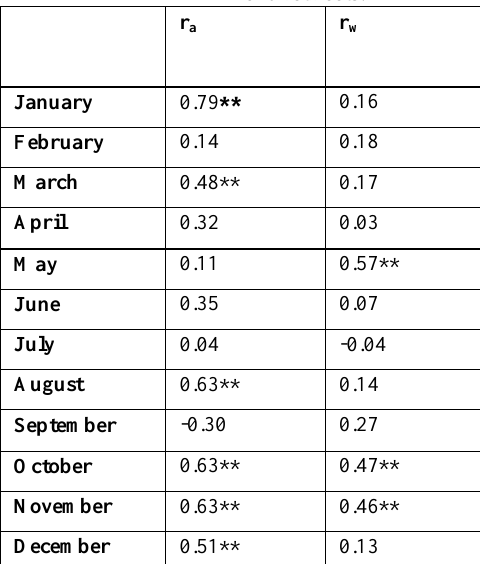
Figure 1. The inferred AQI and the observed AQI in January Table 2. Correlation coefficient between AQI and app messages and retweets.